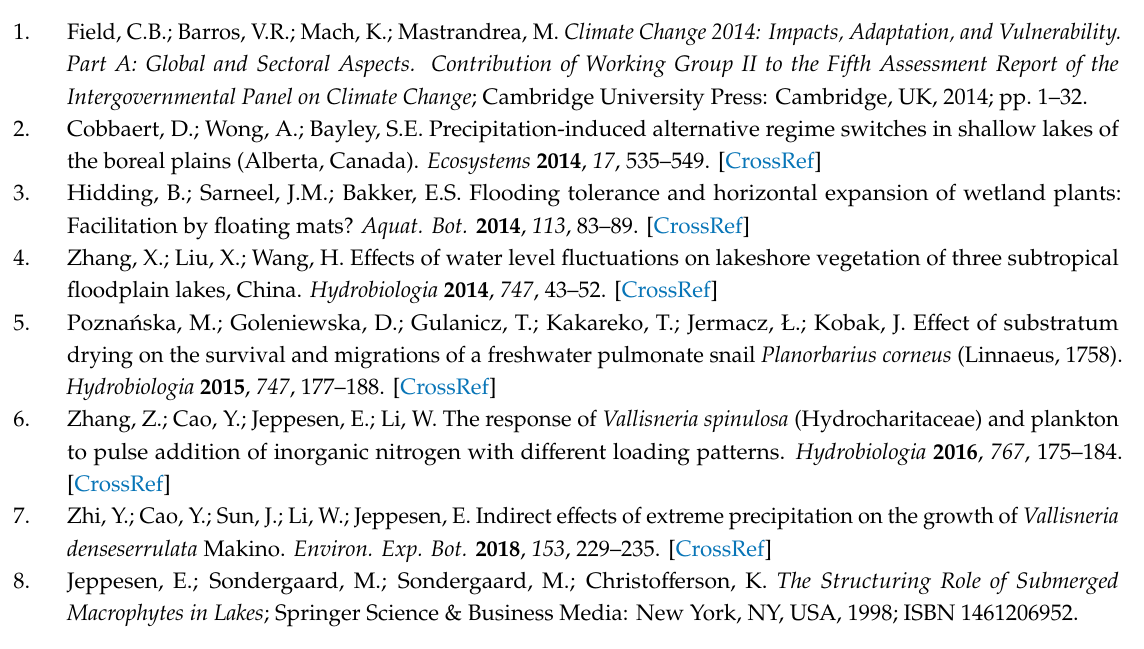
of the five submerged macrophyte species used at the end of the experiment for three macrophyte community treatments (MC1, MC2 and MC3) and four extreme precipitation treatments (EP: C, C_N, E, and G). Vd = Vallisneria denseserrulata ; Hv = Hydrilla verticillata ; Pl = Potamogeton lucens ; Cc = Cabomba caroliniana ; Chara = Chara sp. , Figure S4: Correlation analysis between the three categories of leaf intactness of Vallisneria denseserrulata and snail biomass (and abundance). Leaf intactness was categorised into intact, minor and major damages. The number on the upper diagonal is the Pearson correlation coe ffi cient, r, and the star (*) indicates the significance level: * = p < 0.05; *** = p < 0.001, Figure S5: Correlation analysis between the three categories of leaf intactness of Potamogeton lucens and snail biomass (and abundance). Leaf intactness was categorised into intact, minor and major damages. The number on the upper diagonal is the Pearson correlation coe ffi cient, r, and the star (*) indicates the significance level: * = p < 0.05; ** = p < 0.01; *** = p <